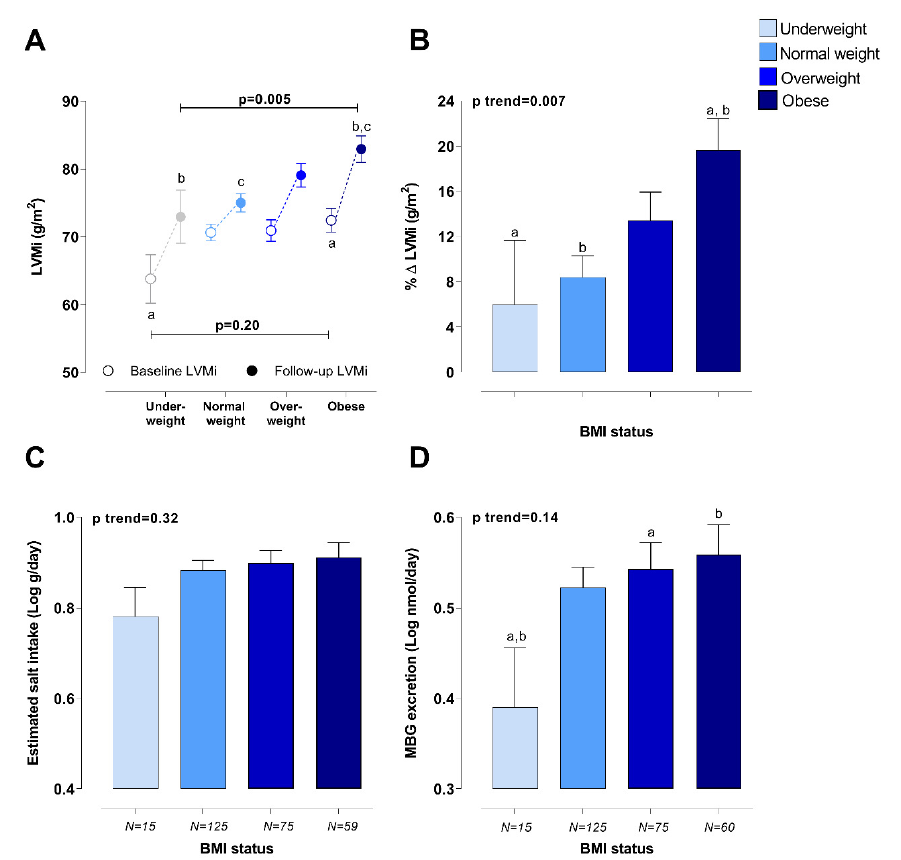
Figure 1. Comparison of ( A ) LVMi, ( B ) percentage change in LVMi, ( C ) baseline estimated salt intake, and ( D ) baseline MBG excretion levels of participants with di ff erent BMI categories at baseline. Adjusted for sex, ethnicity, and age (follow-up LVMi and percentage change in LVMi additionally adjusted for baseline LVMi). a,b,c Indicate significant di ff erence between BMI categories, where data points or bars with the same superscript letter di ff er significantly ( p < 0.05).